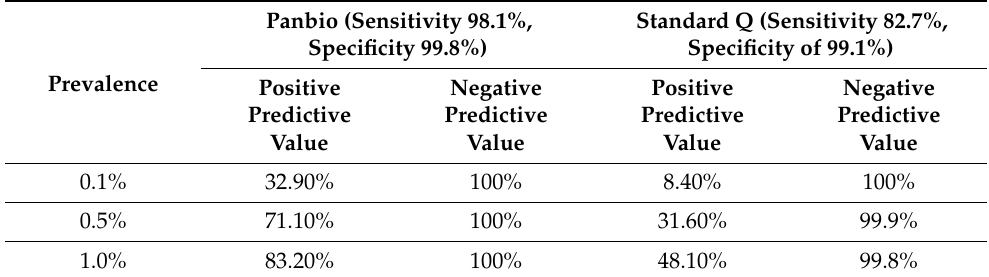
Table 1. The effect of disease prevalence on the positive and negative predictive values of the Panbio and Standard Q rapid antigen